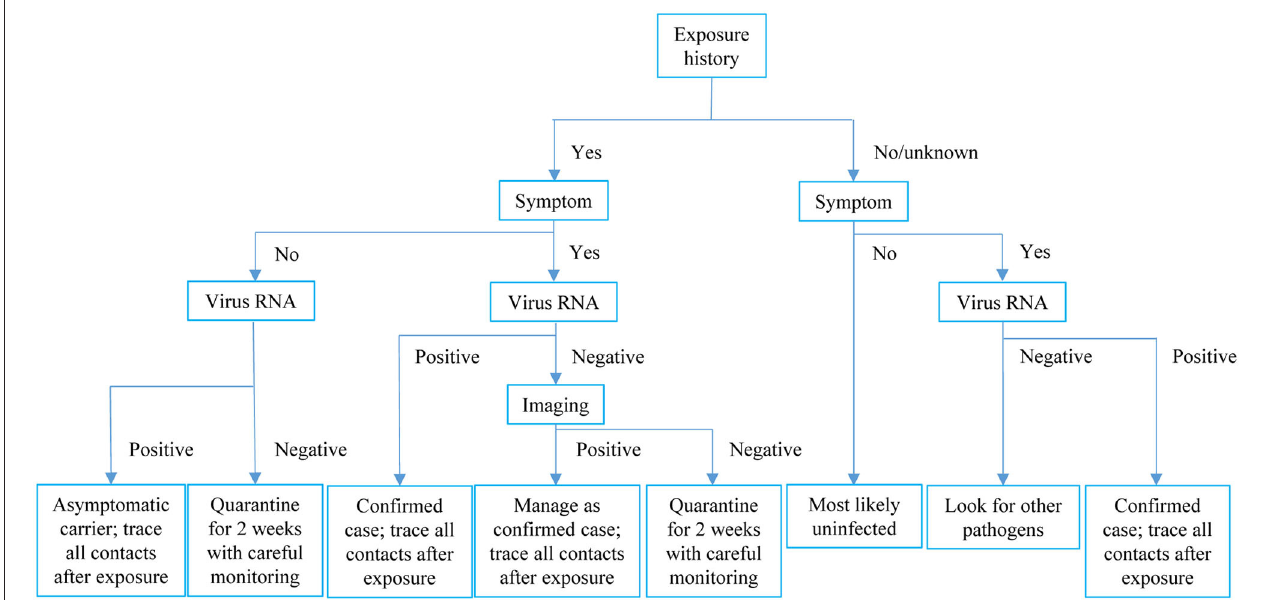
FIGURE 3 | Recommended clinical pathway for COVID-19 in the resource-limited pandemic era.